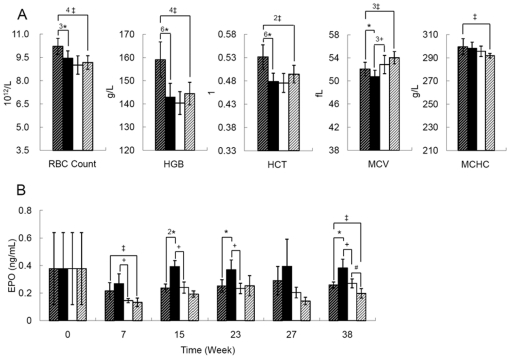
Evidence that CO treatment promotes increased erythropoiesis by an erythropoietin-independent mechanism.(A) Red blood cell indices of B6 mice on garlic-supplemented or garlic-free (cellulose-supplemented) diets with or without the treatment of CO at week 38: red blood cell concentration (RBC count, 1012/L), hemoglobin concentration (HGB, g/L), hematocrit (HCT, %), mean corpuscular volume (MCV, fL), mean corpuscular hemoglobin concentration (MCHC, g/L). Statistics: +, Air-Cellulose (AC) vs. Air-Garlic (AG); ‡, CO-Cellulose (COC)vs. CO-Garlic (COG); * CO-Cellulose (COC) vs. Air-Cellulose (AC); #, Air-Garlic (AG) vs. CO-Garlic (COG). One symbol, p<0.05; 2 symbols, p<0.01; 3 symbols, p<0.005; 4 symbols, p<0.001; 6 symbols, p<0.0001 (student’s t test); n = 7–10. The arrangements for each block of bars are (left to right): thick cross-hatched bars, cellulose diet and treated with CO (COC); filled bars, cellulose diet and treated with air (AC); open bars, garlic diet and treated with air (AG); thin cross-hatched bars, garlic diet and treated with CO (COG). (B) Plasma erythropoietin (EPO) levels (ng/mL), n = 4 for each set of samples at different point of the time course. Symbols are the same as those in Panel A. The pairwise comparisons between AC and COG are: week 7, p<0.013; week 15, p<0.003; week 23, p = 0.065; week 27, p = 0.084; week 38, p<0.007 (student's t test).